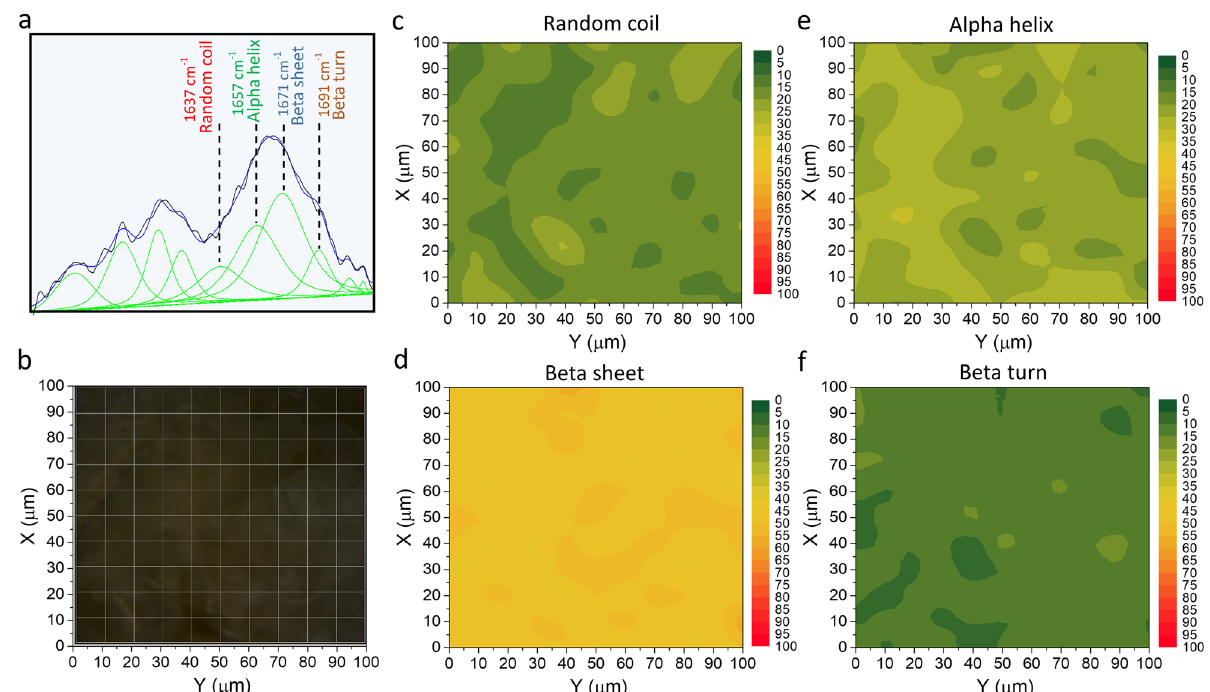
Figure 10. Raman spectrum of AAF with visible deconvoluted curves in the range from 1530 cm −1 to 1710 cm −1 ( a ) photograph of the analyzed AAF surface with the grid of Raman spectra measurements; ( b ) Raman maps presenting the percentage distribution of the random coil; ( c ) beta sheet ( d ) alpha helix ( e ) and beta turn ( f ) structures on the AAF